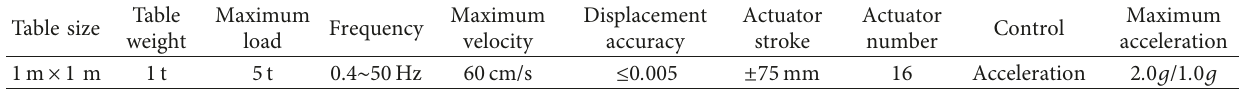
Table 2: Performance indices of 9-table seismic array.